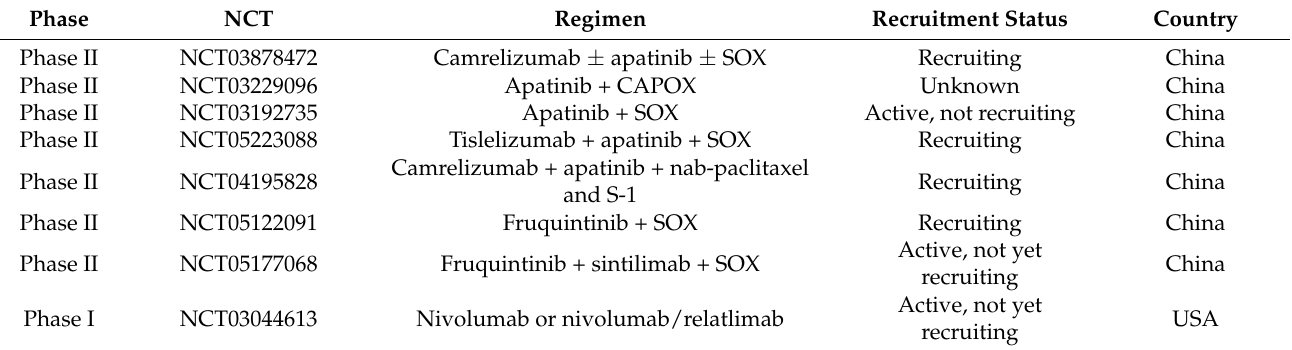
Table 3. Summary of the main trials on agents directed against novel targets in resectable G/GEJ